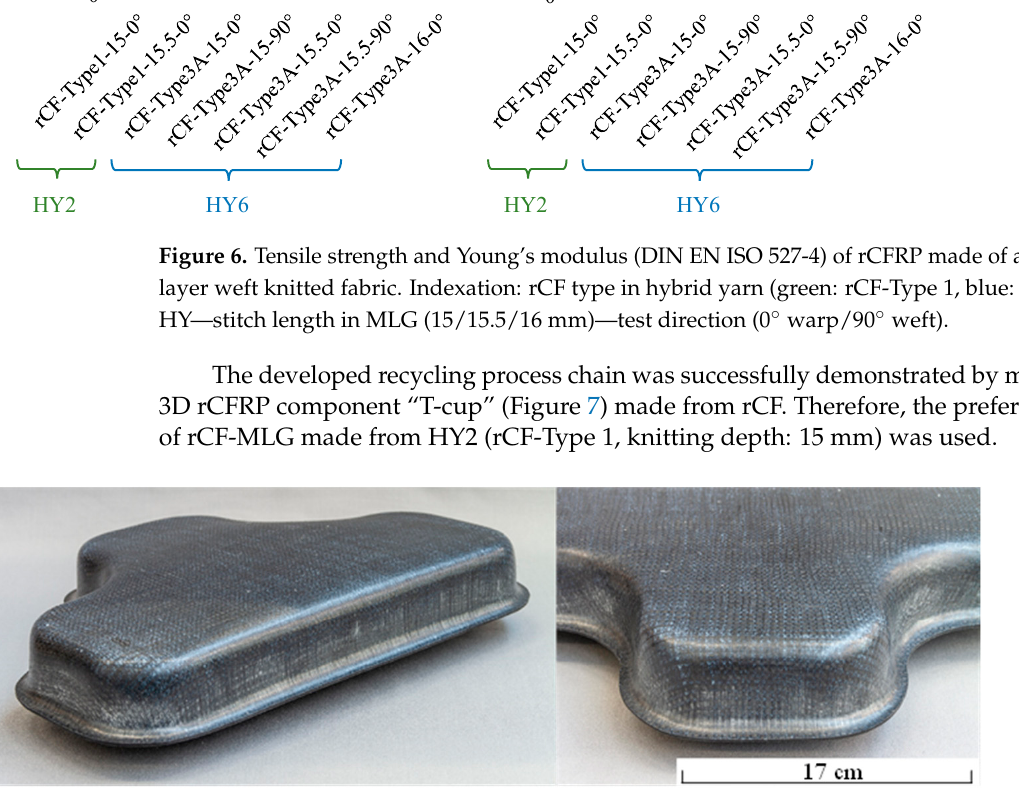
Figure 7. Realized 3D-rCFRP demonstrator “T-cup.” Figure 6. Tensile strength and Young’s modulus (DIN EN ISO 527-4) of rCFRP made of an rCF multi-layer weft knitted fabric. Indexation: rCF type in hybrid yarn (green: rCF-Type 1, blue: rCF- Type 3); HY—stitch length in MLG (15/15.5/16 mm)—test direction (0° warp/90° weft).